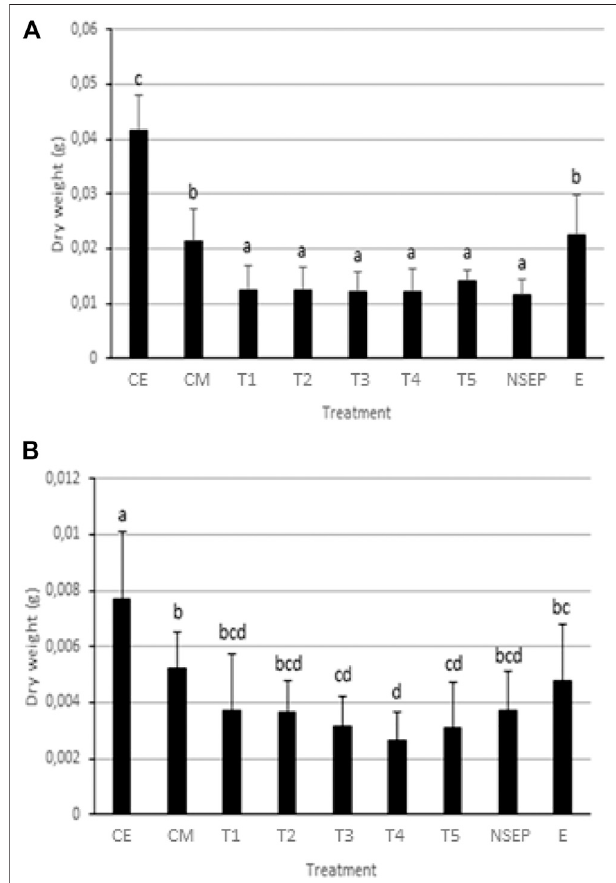
FIGURE 4 | Mean dry weight (DW) of Secale cereale (rye) (A) and Lepidiumsativum(cress) (B )indifferenttreatments,with n (cid:2) 12per treatment. CE (cid:2) Control Earth (Potting soil), CM (cid:2) Control Mars regolith simulant, T1 (cid:2) SEP 5 days before sowing, T2 (cid:2) 4 days after sowing (a.s.), T3 (cid:2) 7 days a. s., T4 (cid:2) 14 days a. s., T5 (cid:2) 21 days a. s., NS (cid:2) No SEP, E (cid:2) Earth (Potting soil), No SEP. Signi fi cant differences ( p < 0.01) between treatments are indicated by different letters plotted above the bars. Error bars represent positive standard errors of the treatment